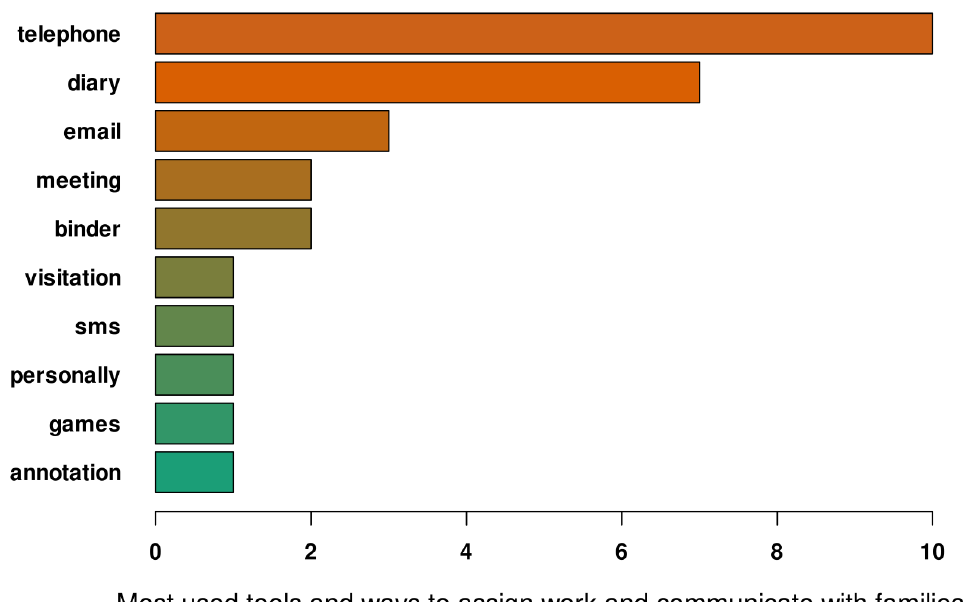
Figure 7. The tools and strategies SLTs use to work with